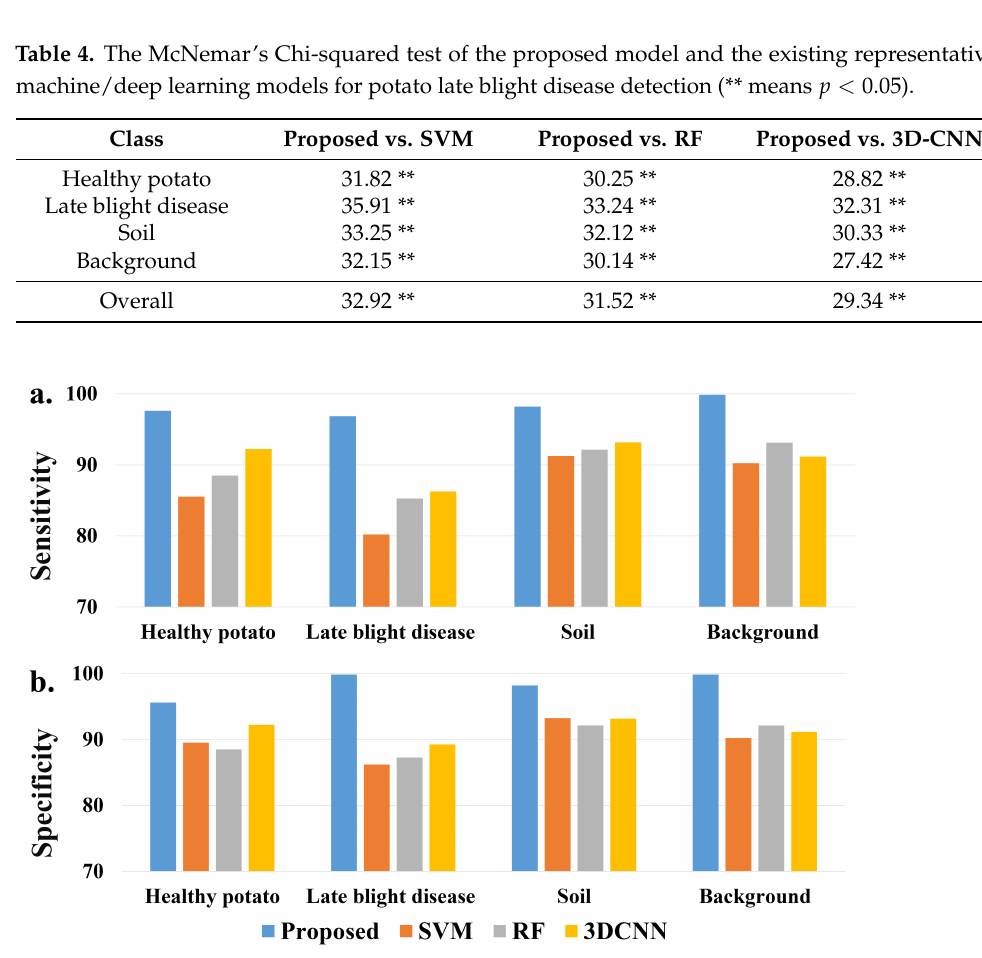
Figure 4. A comparison of ( a ) sensitivity and ( b ) specificity of each class from different